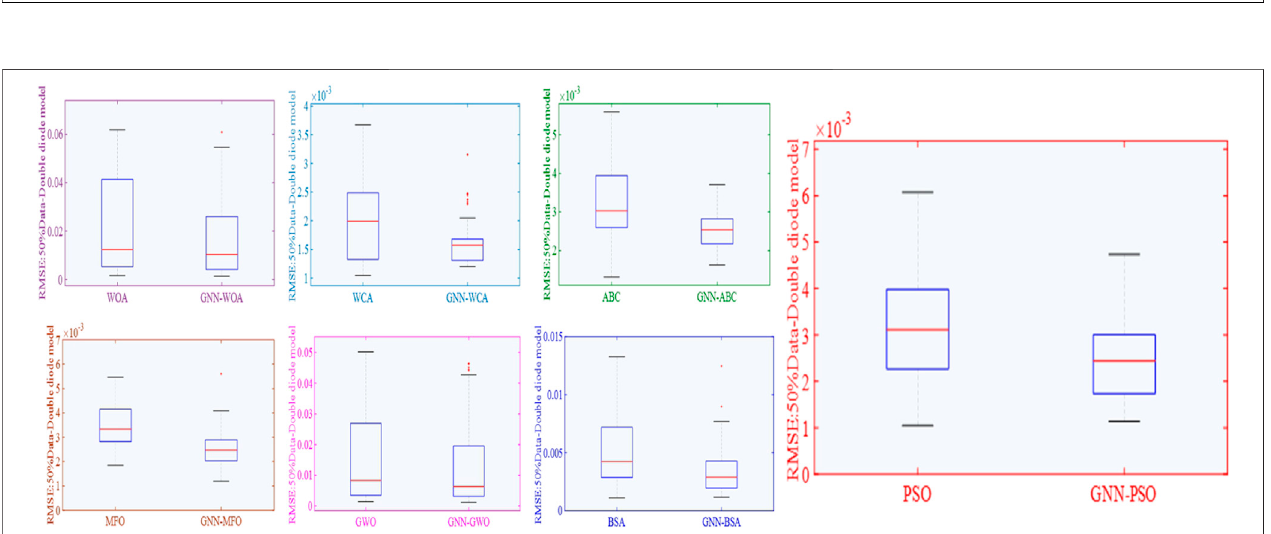
FIGURE 10 | Boxplot of RMSE under different data for the DDM under 50%